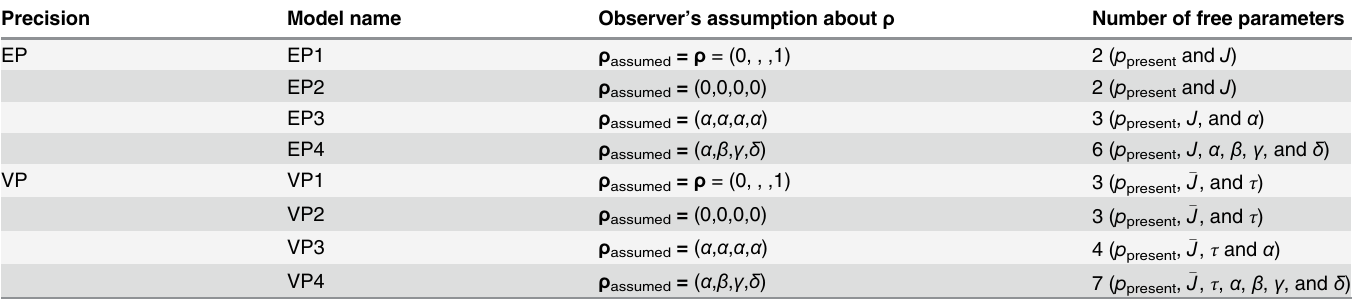
Table 1. Summary of models. The models are organized according to two factors: the presence of variability in measurement precision (EP and VP), and the observer ’ s assumption about the correlation coefficients, ρ .